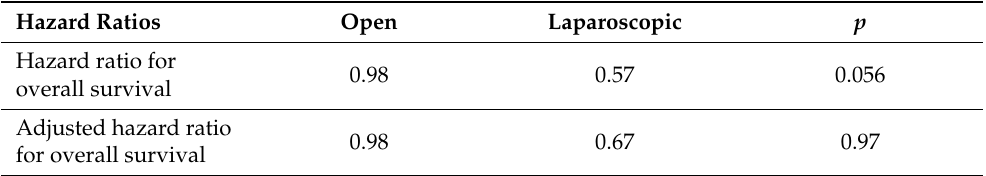
Table 4. Multivariate analysis: Cox proportional hazard regression model according to surgical technique. Hazard Ratios Open Hazard ratio for overall